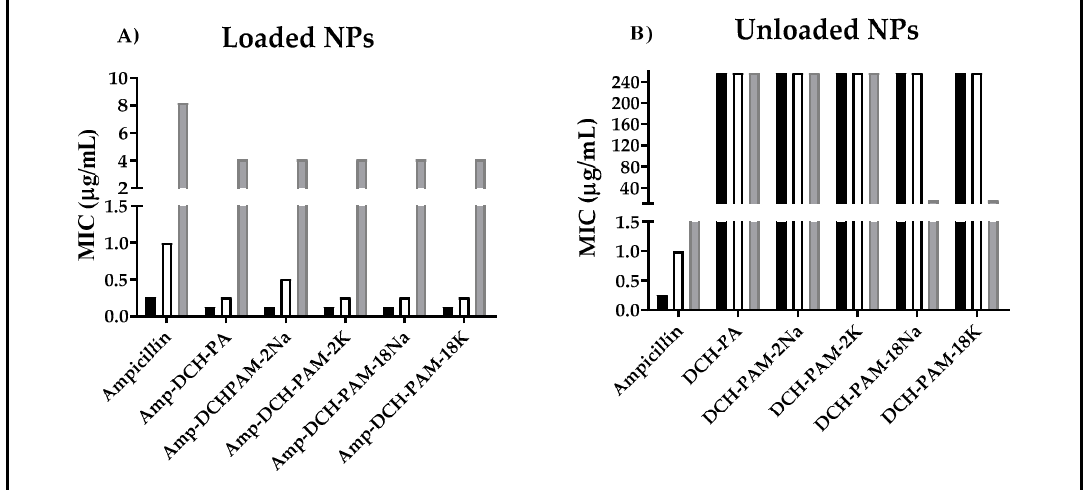
Figure 4. Minimum inhibitory concentration for ( A ) ampicillin–chitosan–polyanion nanoparticles and ( B ) blank chitosan–polyanion nanoparticles.